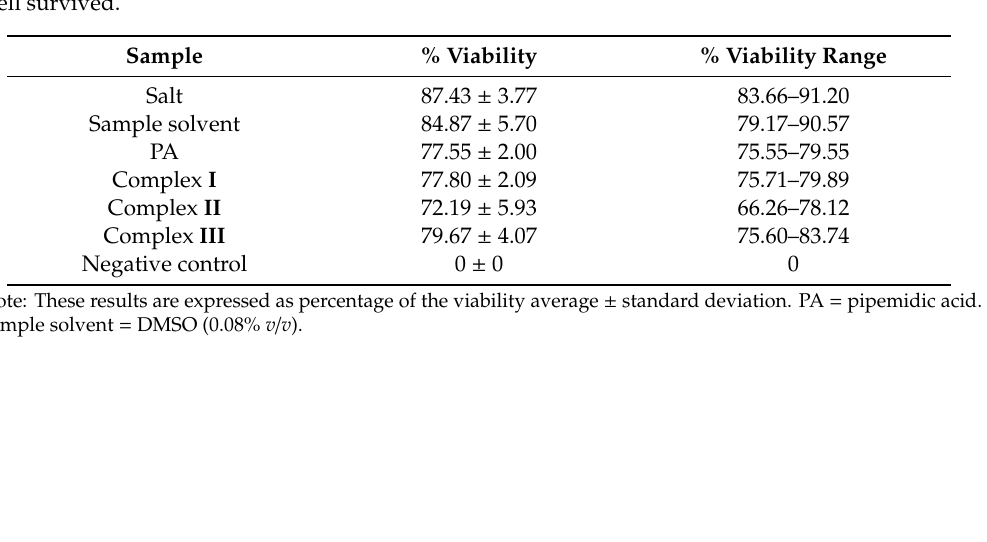
Table 3. Viability of Artemia salina after 24 h in the presence of 8 µ g / mL of complexes I , II and III . After 24 h in the presence of 10% DMSO (% v / v , negative control), none of the Artemia salina in the respective well